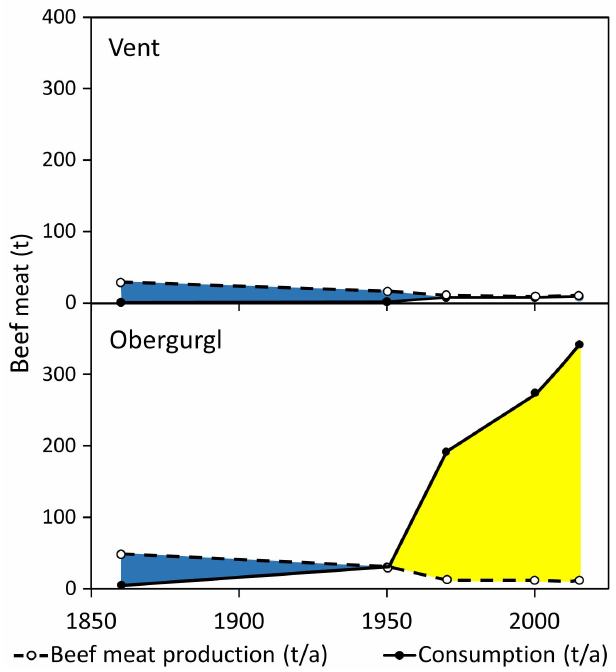
Fig. 4 . The beef balance for the villages Vent and Obergurgl. Blue shading indicates the export of beef (supply > demand), yellow shading indicates the import of beef (supply <